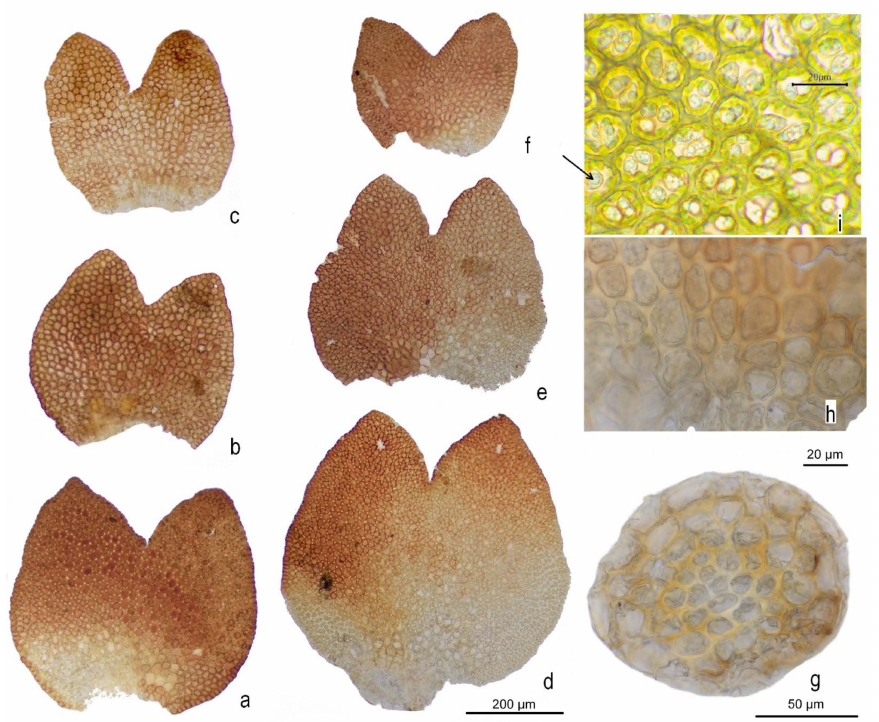
Figure 4. Marsupella lusitanica R.D. Porley & Jan Kuˇcera, detail microphotographs: ( a – f ) vegetative leaves; ( g ) stem cross-section; ( h ) basal cells; ( i ) mid-lobe cells showing the oil bodies; arrow to biconcentric oil body. ( a – c , g ) from holotype, Porley s.n. , ( d – e ) from Kuˇcera 10685 , paratype 8, ( f , h ) from Kuˇcera 10623 , paratype 7, ( i ) from Porley s.n. , paratype 3. Description. Plants small, in low mats or patches closely attached to rock, brown to brownish-ochre, young growth yellowish-green, black to purplish-black when dry,